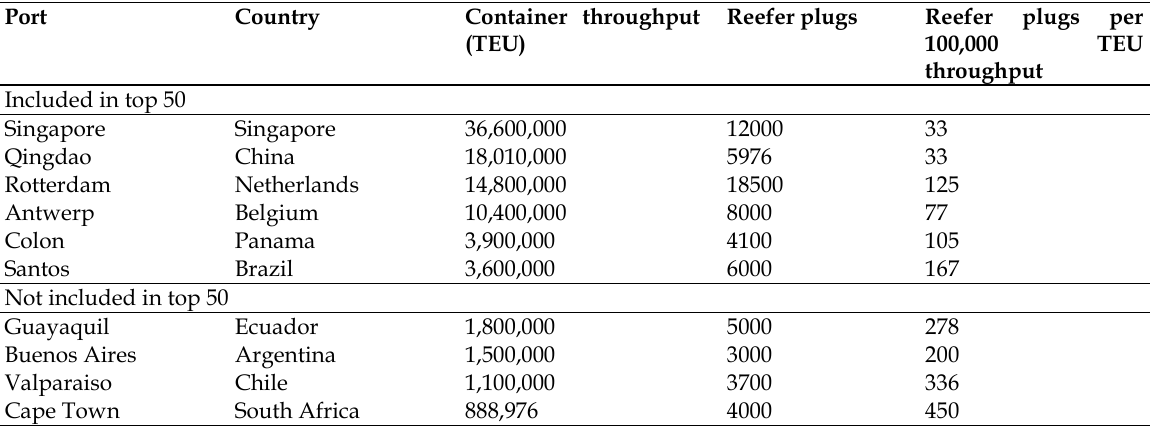
Table 3. Comparing the of reefer plugs for select top 50 and non-top 50 container